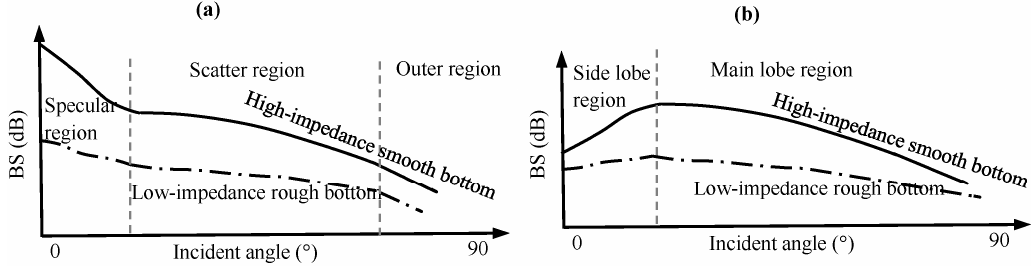
Figure 2. Incident angle—backscatter strength (BS) curves of MBES ( a ) and SSS ( b ) with different types of sea bottom.